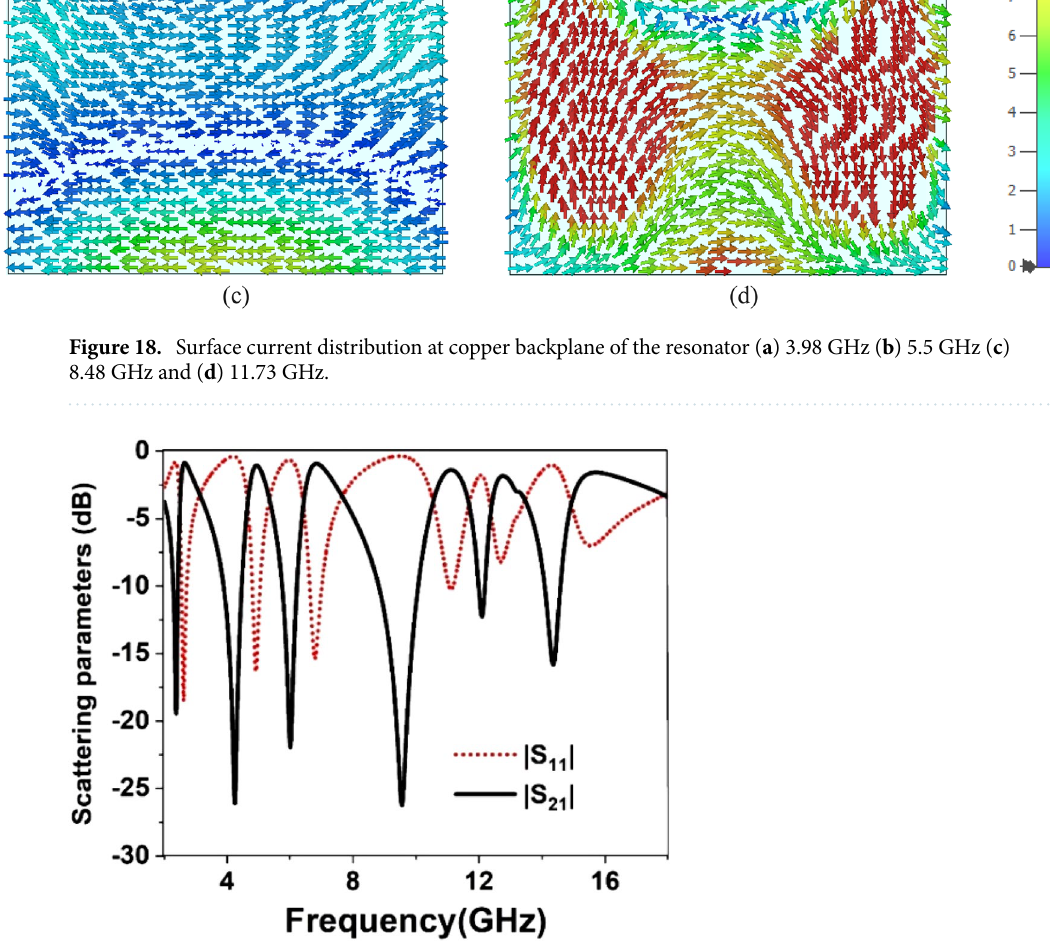
Figure 19. Transmission coefficient and reflection coefficient of the unit